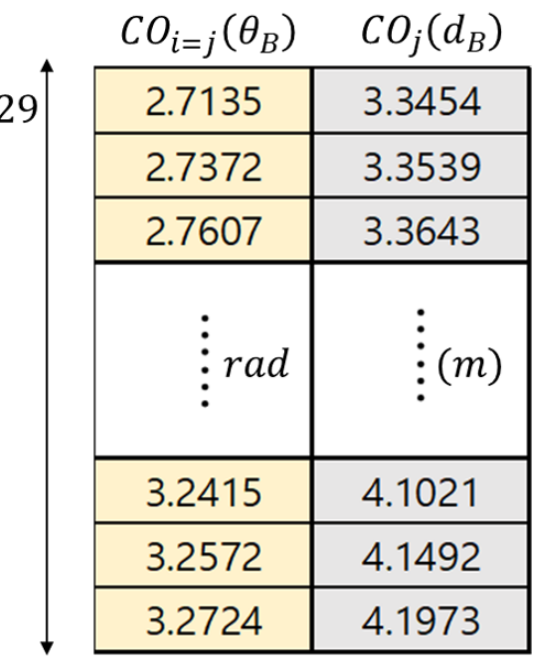
Figure 10. The two 29 by 1 matrices about CO i = j ( θ B ) and CO j ( d B ) . Figure 11 is the resulting graph of a generated obstacle image into ( x , y , z ) ∈ S 3 , which is made up of many points. The θ boom , B , θ stick , B , and θ bucket , B must not be to avoid the collision. Especially, the asterisk in the obstacle image is made meaningfully for verification. This comes from the third occasion, collision. All joints are being in the area where must not